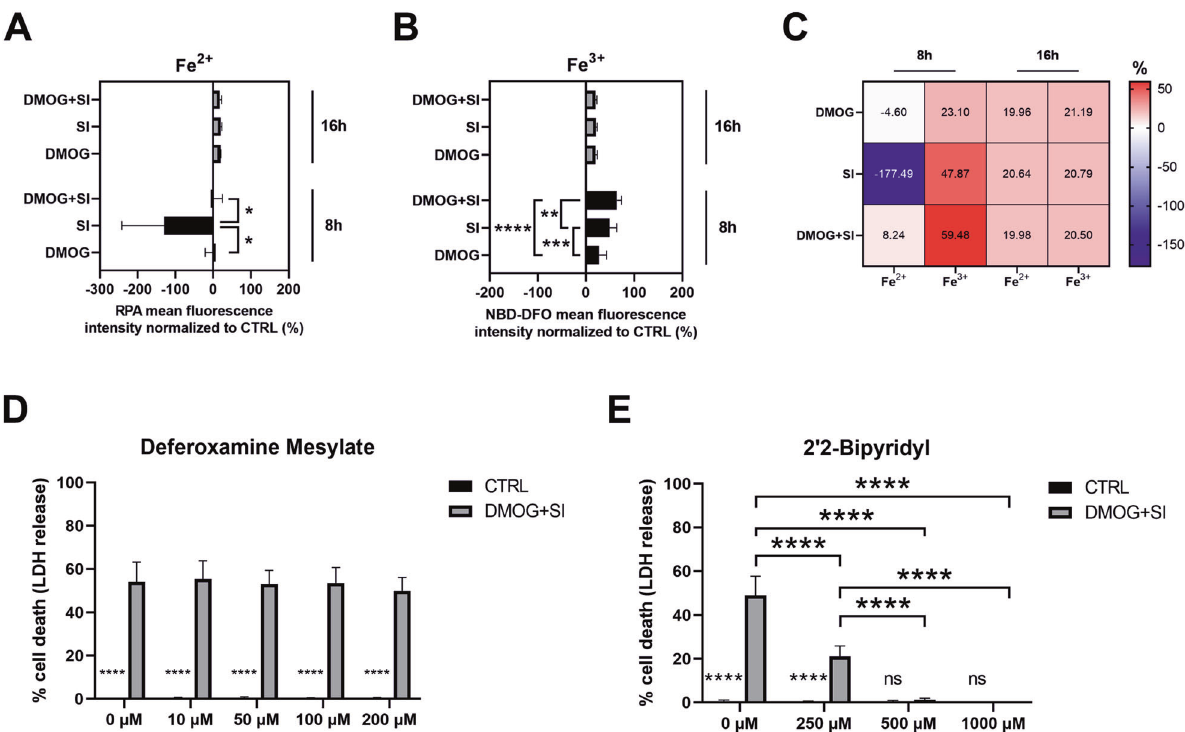
Fig. 5 DMOG + SI co-treatment is likely to promote the Fenton reaction in DMOG + SI co-treated ARPE-19 cells. A – C The Fe 2 + -speci fi c fl uorescence sensor RPA revealed signi fi cantly lower Fe 2 + levels in SI-treated cells compared to controls after 8 h at 3% O 2 while no difference between controls and DMOG + SI co-treated cells were detected. In contrast, Fe 3 + levels were signi fi cantly increased by DMOG + SI co- treatment compared to the other treatment groups after 8 h, which was assessed with the Fe 3 + -speci fi c fl uorescence sensor NBD-DFO. After 16 h, iron levels were similar in all treatment groups. While chelation of Fe 3 + by Deferoxamine Mesylate ( D ) did not improve cell viability, Fe 2 + chelation by 2 ’ 2-Bipyridyl E resulted in full rescue of cells suggesting that Fe 2 + plays a detrimental role in DMOG + SI-induced ferroptosis. Data are presented as means + SD. RPA and NBD-DFO assays (3 independent groups) were statistically analyzed with one-way ANOVA and LDH assays were analyzed with two-way ANOVA. SOD2 knockdown (6 independent groups) were analyzed with two-way ANOVA. ns not signi fi